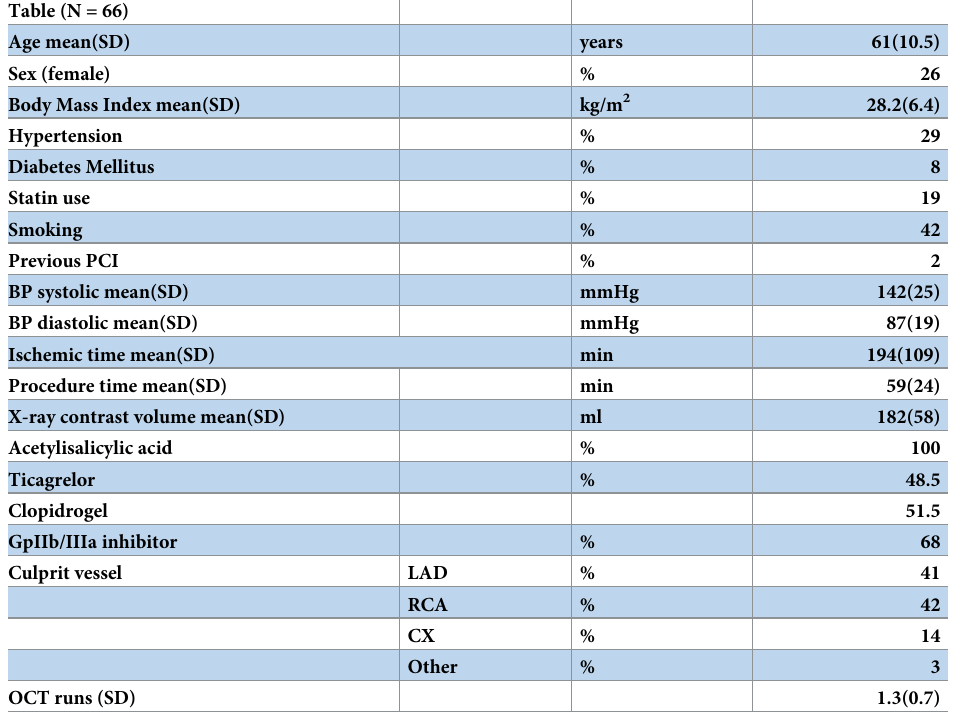
The histological categories red, white and mixed thrombus showed no correlation with inten- sity measurements by Ilumien Optis (p = 0.41) or ImageJ Small ROI (p = 0,48) by One-Way ANOVA. Intensity ratio could not predict the content of erythrocytes (Standardized Beta -0.014, p = 0.93) or platelets (Beta 0.002, p = 0.99) (Ilumien) (Fig 3).